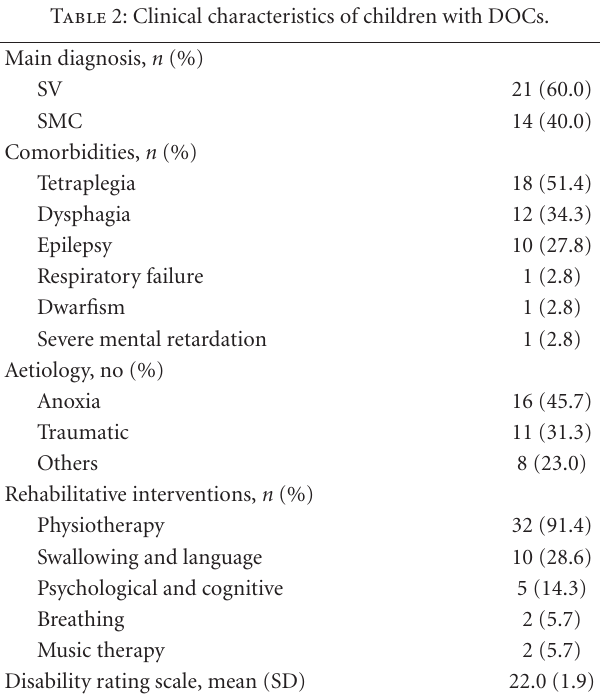
Table 2: Clinical characteristics of children with